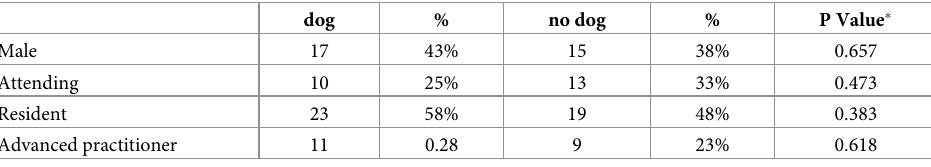
Table 3. Provider